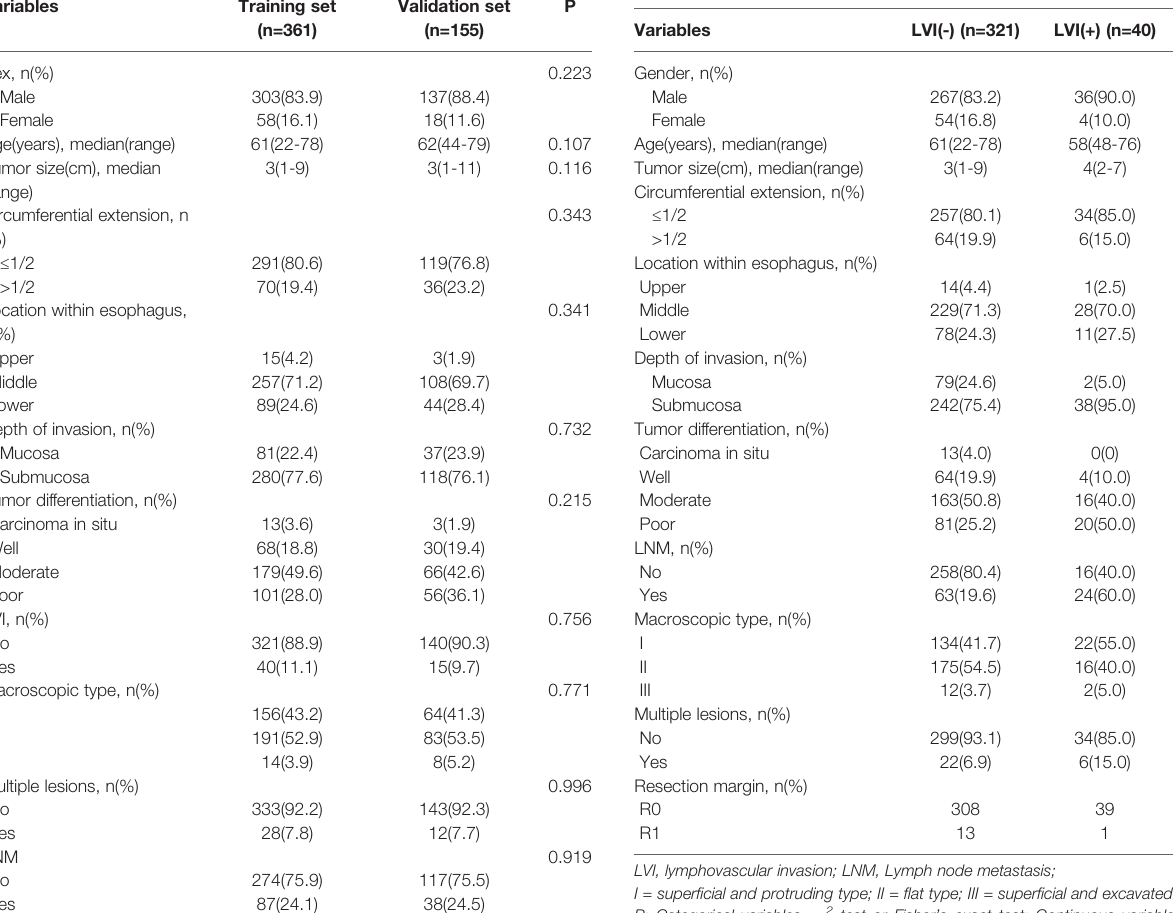
TABLE 1 | Participant characteristics. TABLE 2 | Clinicopathologic fi ndings according to lymphovascular invasion in